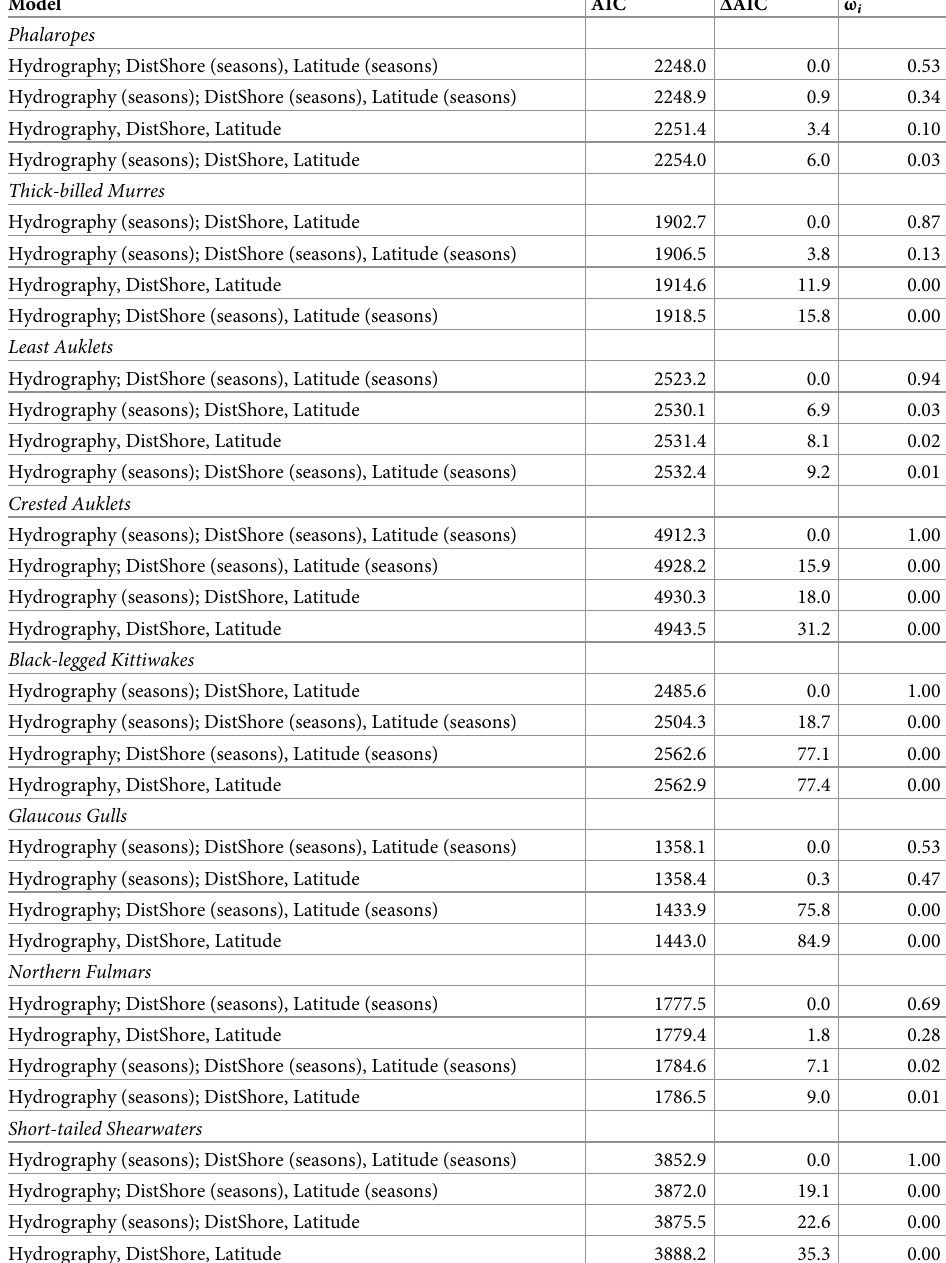
Table 5. Generalized additive models that best explained variation in abundance and distribution of seabirds in the northeastern Chukchi Sea, 2008–2018 (n = 256 hexagonal cells, 30-km from vertex to vertex).